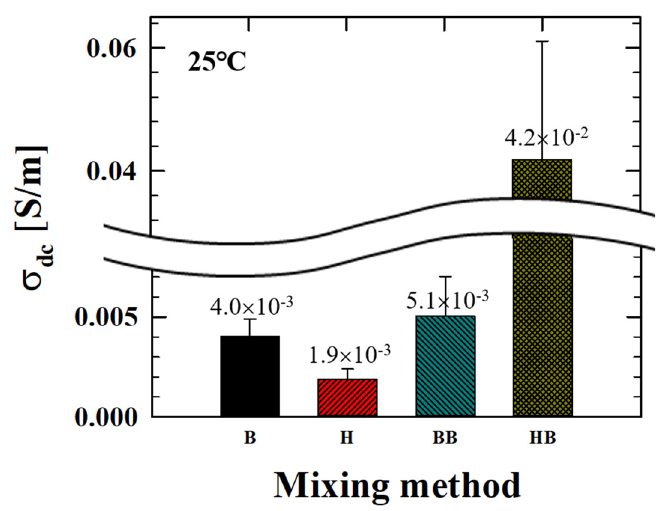
Polymers 2020 , 12 , x FOR PEER REVIEW 10 of 17 Figure 4. Electrical conductivity ( σ dc ) of a ternary composite depending on the mixing method.